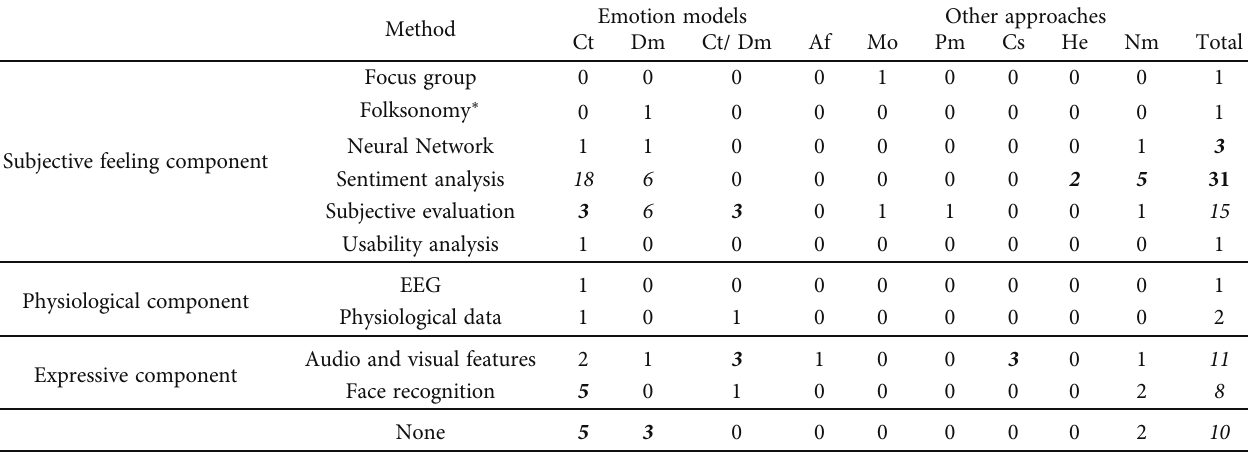
Table 6: Emotion identi fi cation method as a function of the emotional